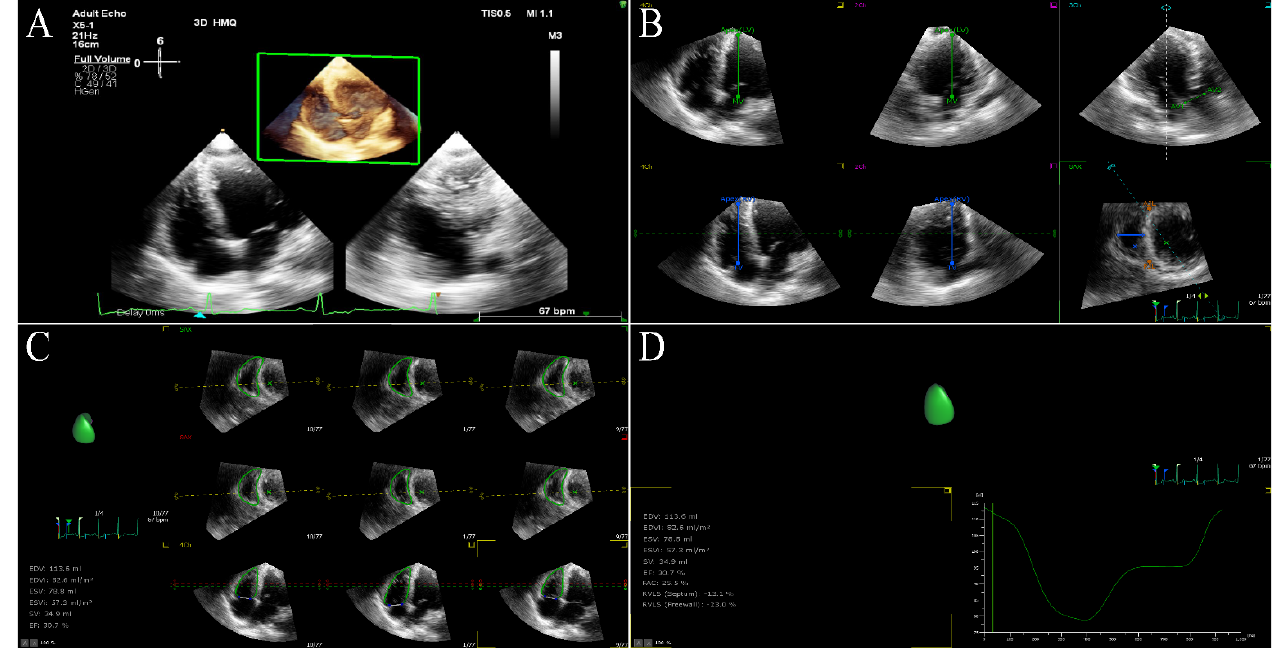
Figure 2. RV three − dimensional strain images in a HFrEF patient. ( A ) Three − dimensional image of RV − focused apical 4 − chamber view. ( B ) Reference points setting. ( C ) RV endocardial border identification and tracking. ( D ) Longitudinal strain of RV-free wall and septum. RV: right ventricular.